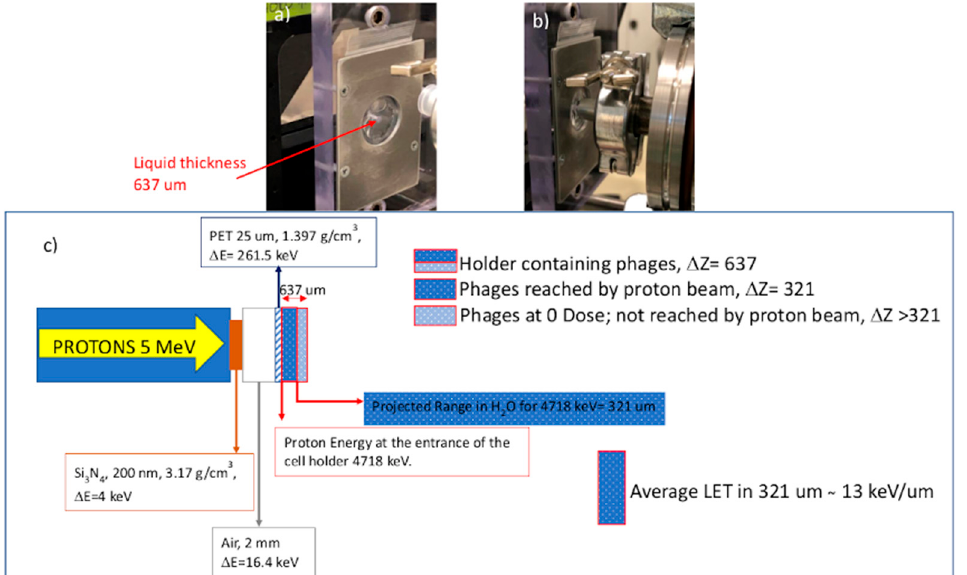
Figure 1. Holder made of PE, containing the phage solution ( a ), detail of the set-up adopted for the proper proton–solution interaction ( b ) and scheme of the proton energy loss in the different materials before hitting the phage solution ( c ).